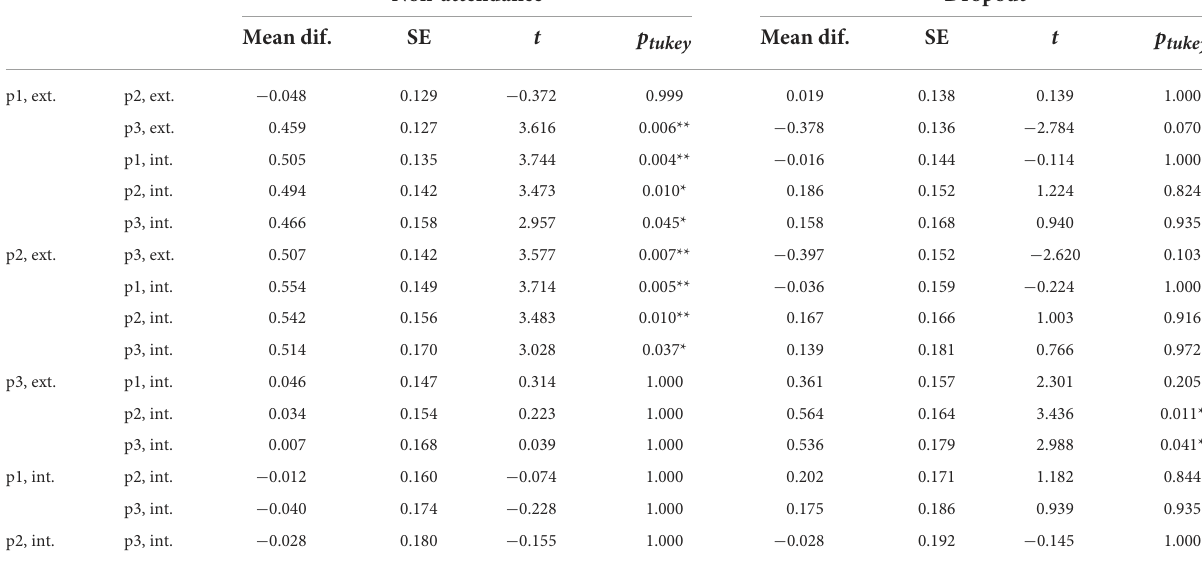
TABLE 3 Post-hoc comparisons - protocol * internal/external. Non-attendance Dropout Mean dif. SE t Mean